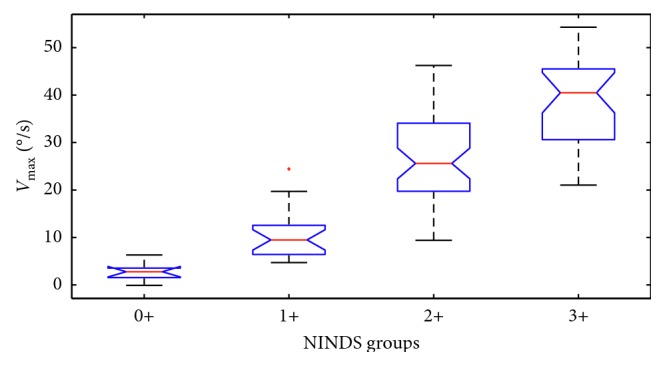
Boxplots of the Vmax feature for each NINDS group.